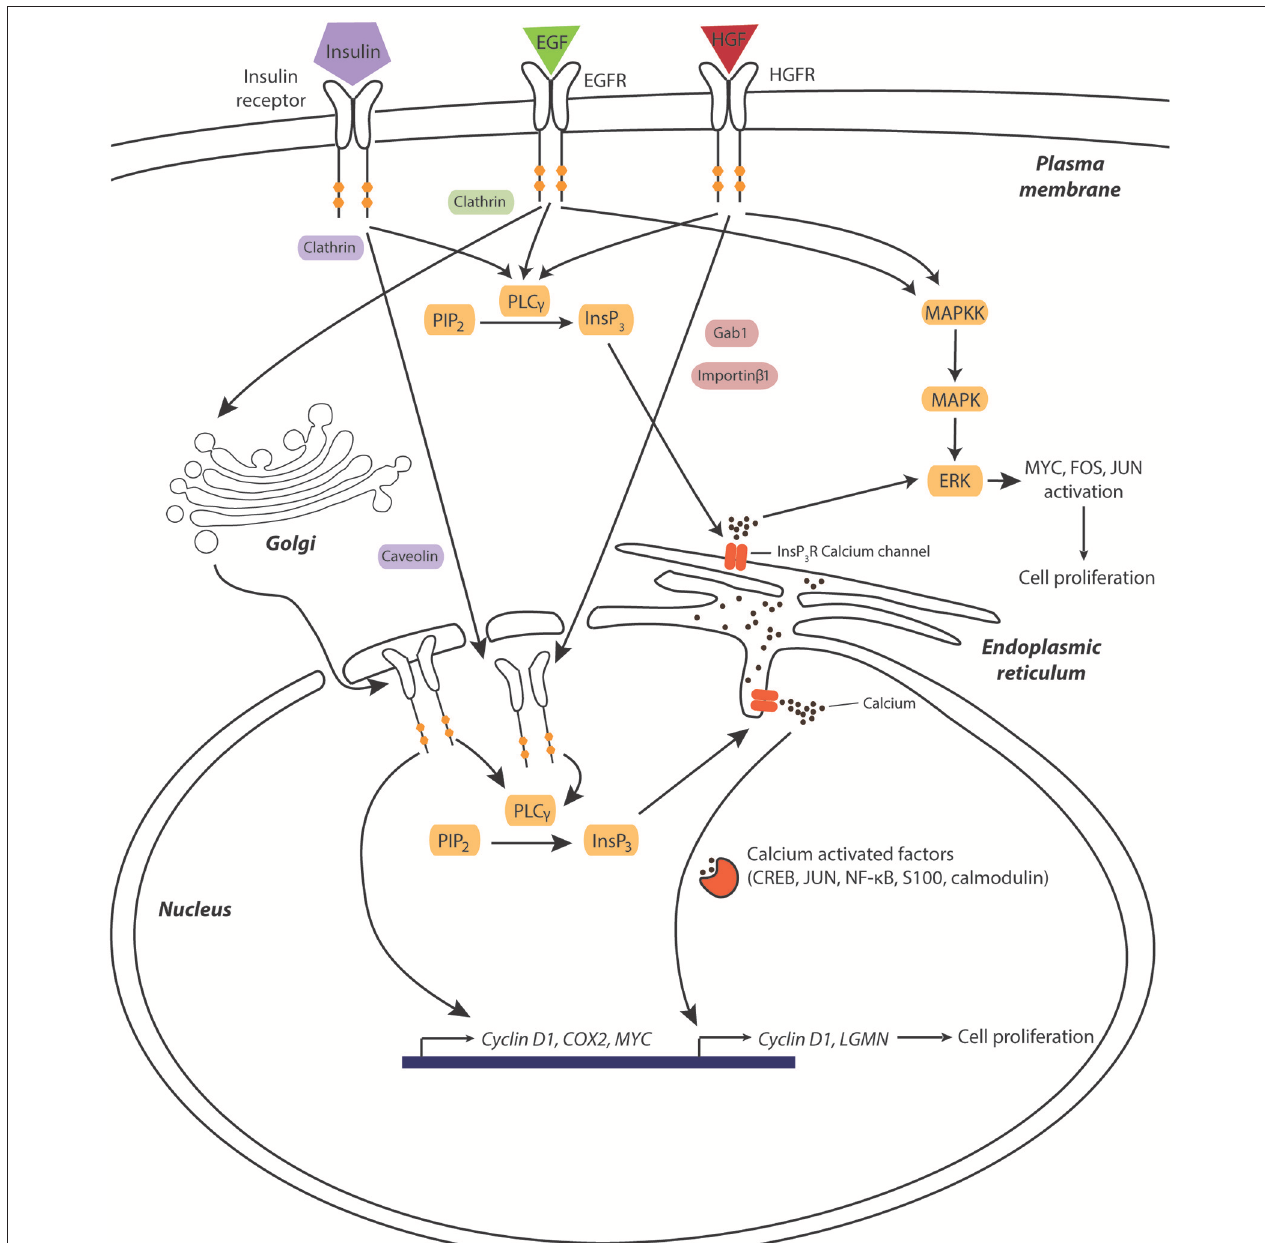
FIGURE 1 | Calcium is a key component of hepatic growth factor signaling during liver regeneration after physical injury. Growth factors induce their mitogenic effects through pathways involving receptor translocation to the nuclear compartment and subsequent triggering of nucleoplasmic calcium release. Increased cytosolic calcium levels activate calcium-dependent transcription factors and kinases, which facilitates cell cycle entry and progression. Furthermore, EGFR directly associates to the promoter of pro-proliferative genes, such as cyclin D1 , COX2 , and MYC . Components involved in EGF-, HGF-, and insulin signaling are shown green, red, and purple, respectively. Signaling molecules shared between pathways are depicted in